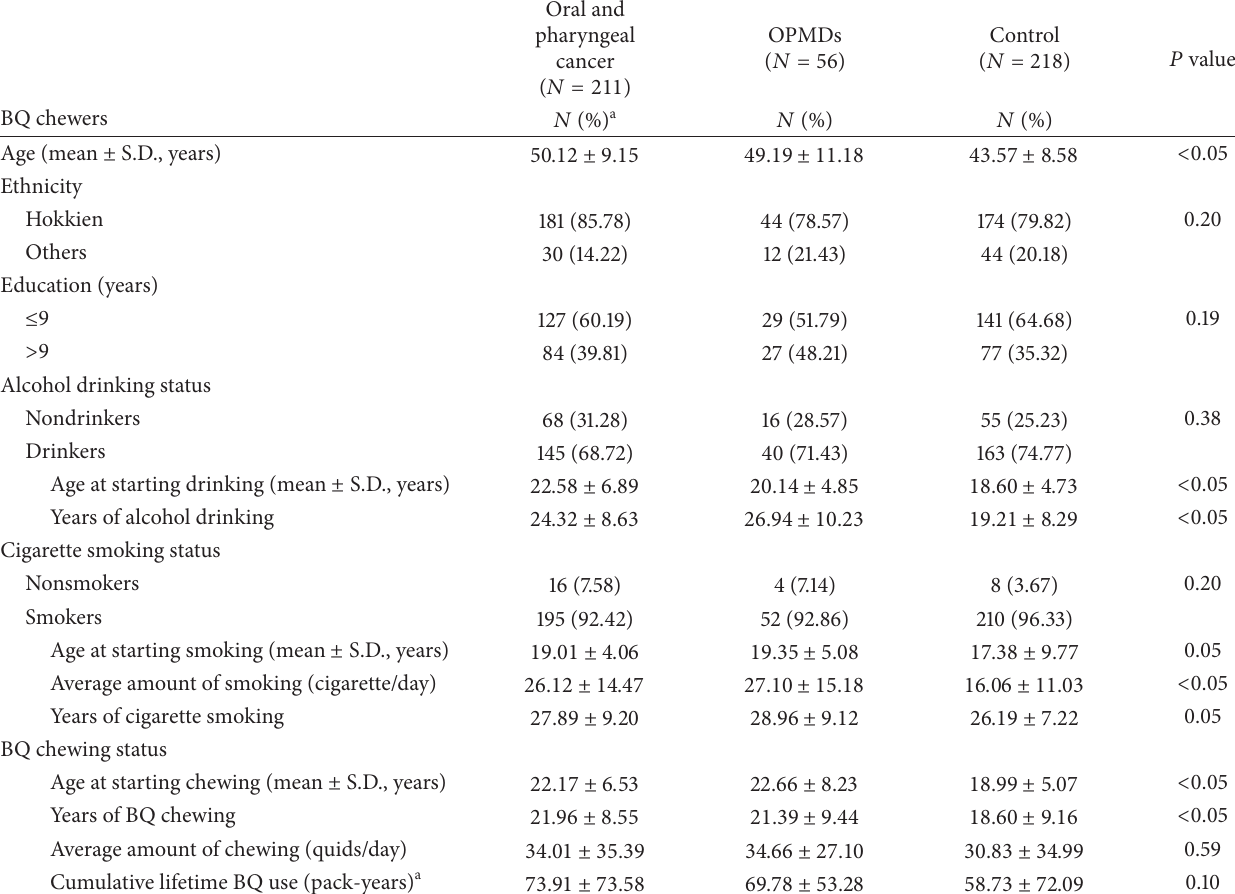
Table 1: Distribution of male betel quid chewers associated with characteristics of selected demographic